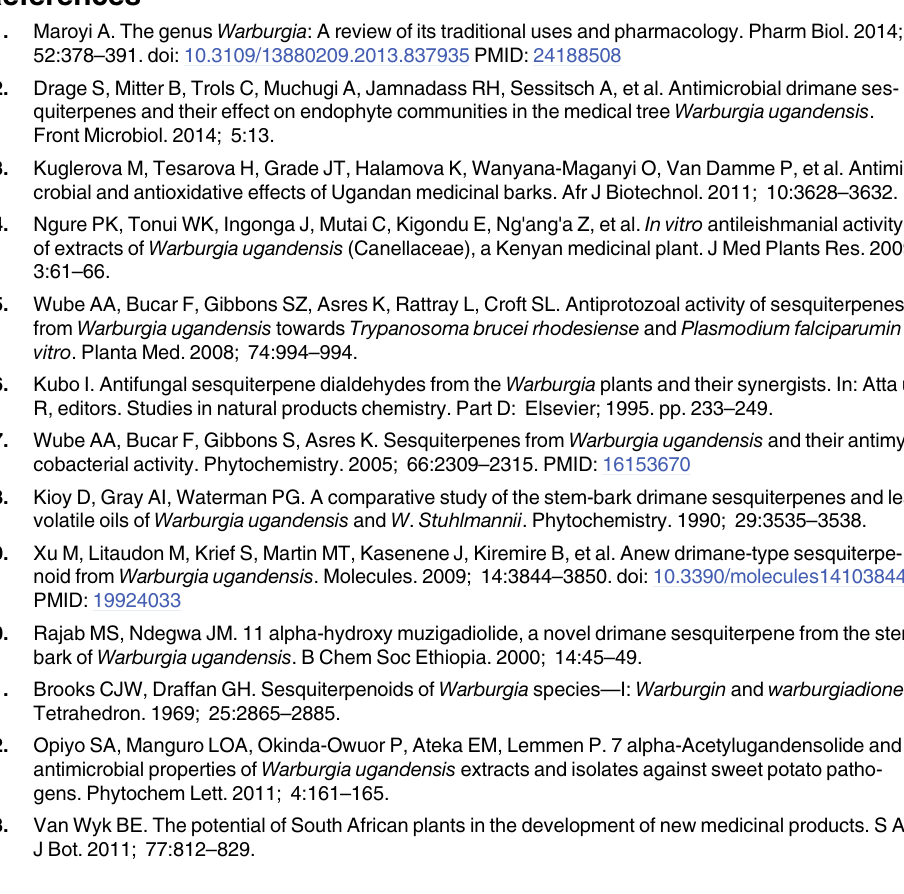
S5 Table. List of DEGs between W . ugandensis stem bark and leaf. S6 Table. GO enrichment analysis of DGEs. S7 Table. KEGG pathway enrichment analysis of DGEs. S8 Table. qRT-PCR primers used in this